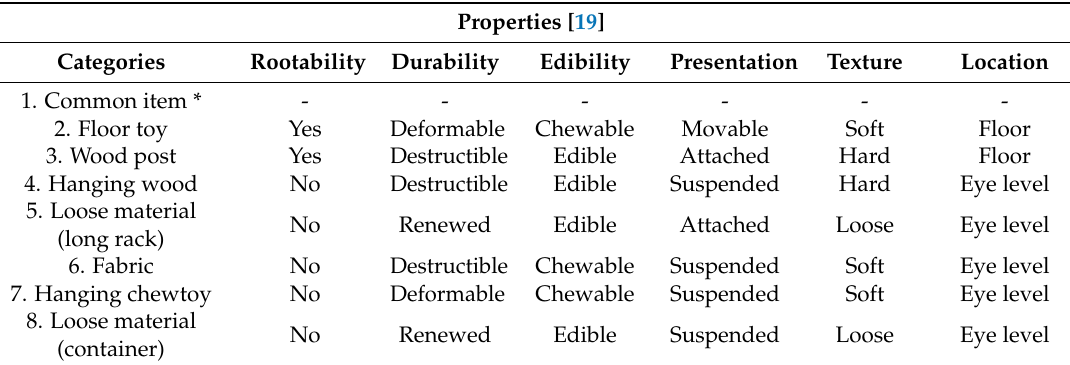
Table 1. The enrichment categories used in the